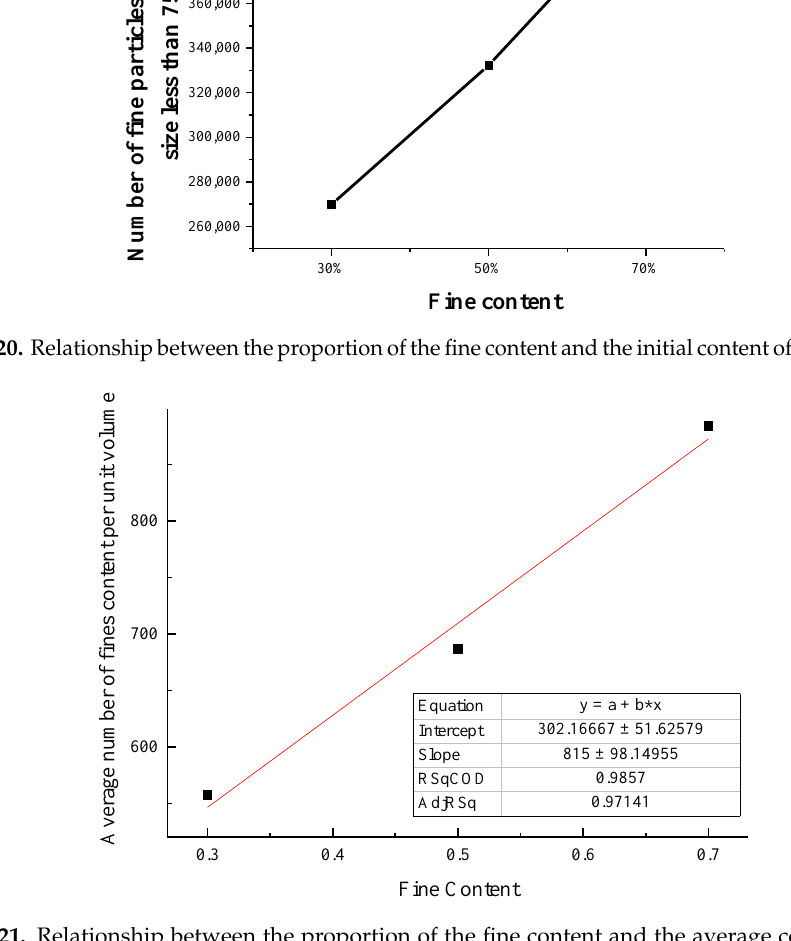
Figure 21. Relationship between the proportion of the fine content and the average content of fine particles per unit volume.